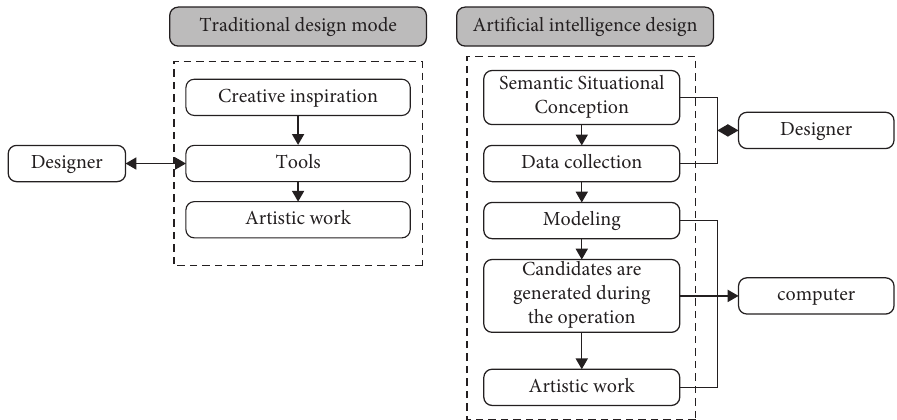
Figure 2: The division of labor between traditional design methods and artificial intelligence design.